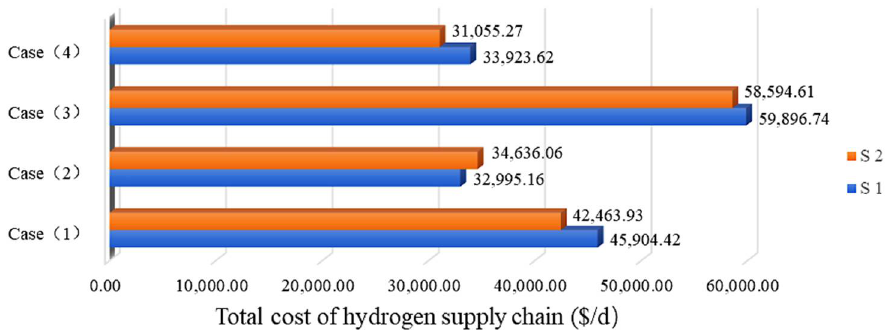
Figure 11. Total cost of hydrogen supply chain about different cases for two scenarios (USD/d).